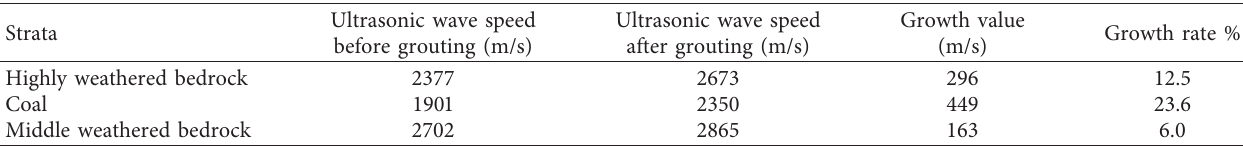
Table 4: Summary of ultrasonic testing